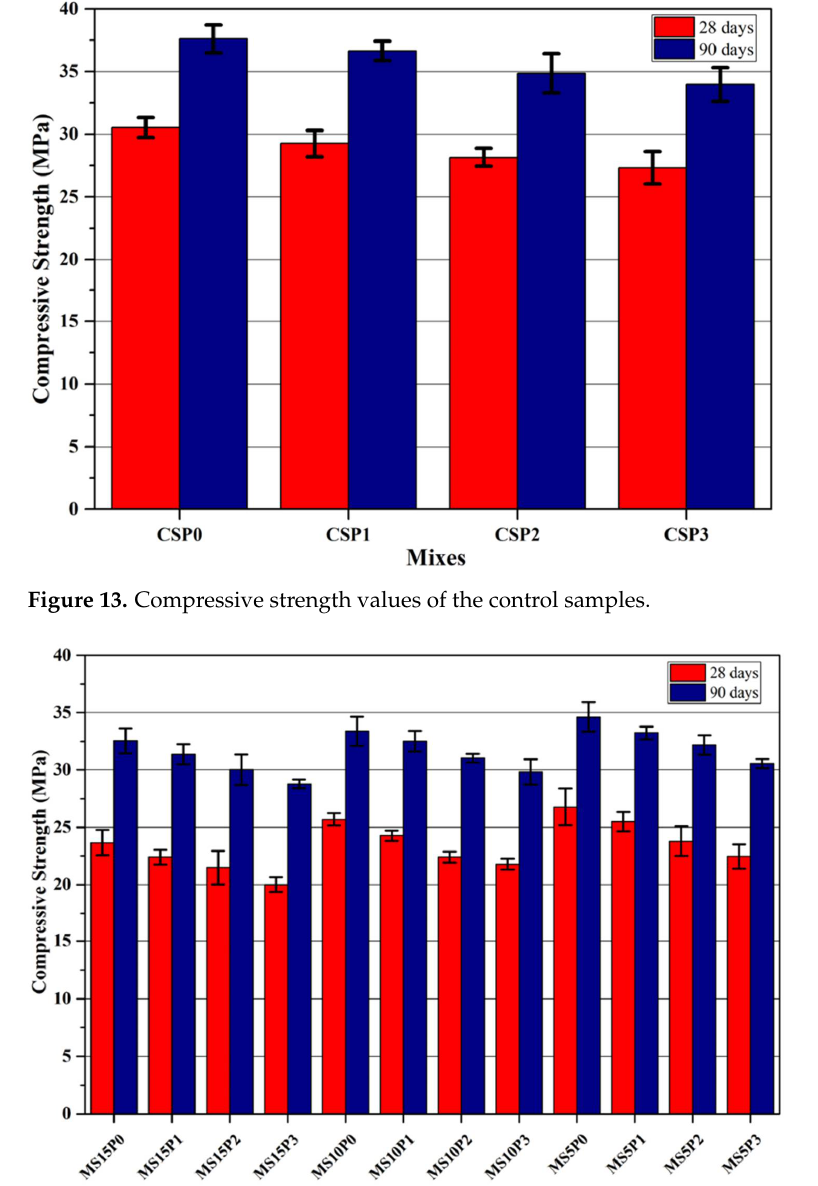
Figure 15. Compressive strength values of the SF samples .